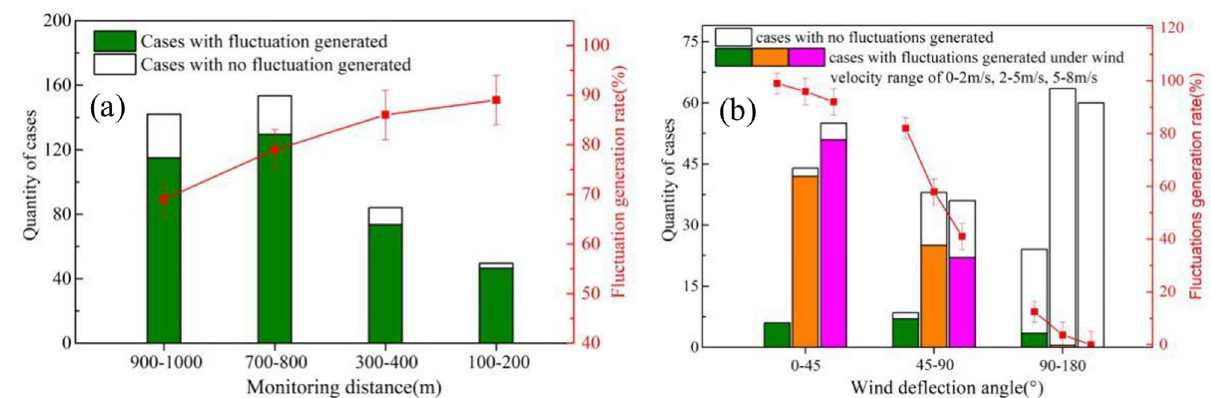
Fig 4. Results of fluctuation generation under (a) different monitoring distance; (b) different wind deflection angle and velocity with monitoring distance of 400m.